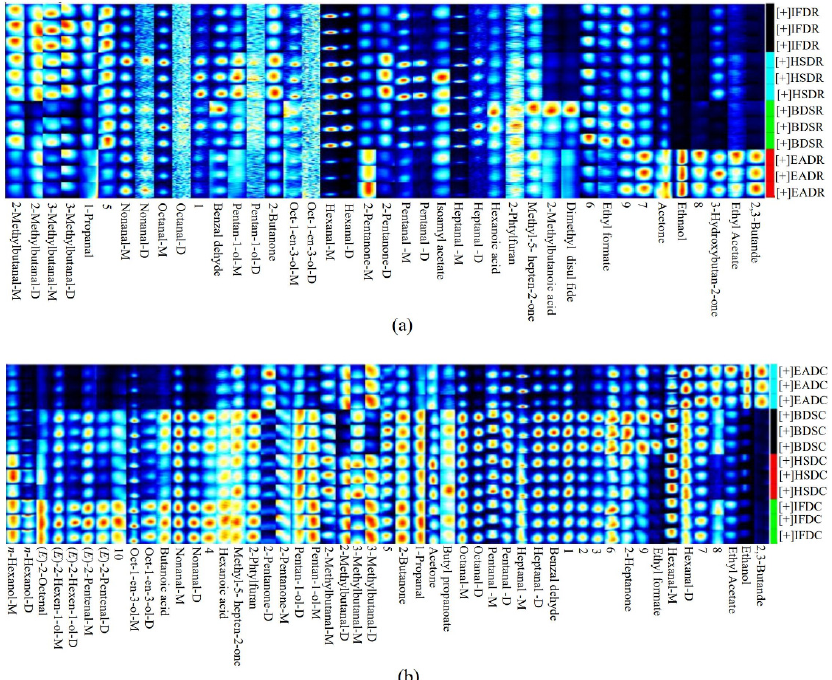
Figure 6. Gallery plot of selected signal peak areas obtained from raw ( a ) and cooked ( b ) sea bass obtained using different slaughter methods. IFD, ice faint to death; HSD, head shot control stun death; EAD, eugenol anesthesia to death; BDS, bloodletting to death; C, cooked; R, raw.